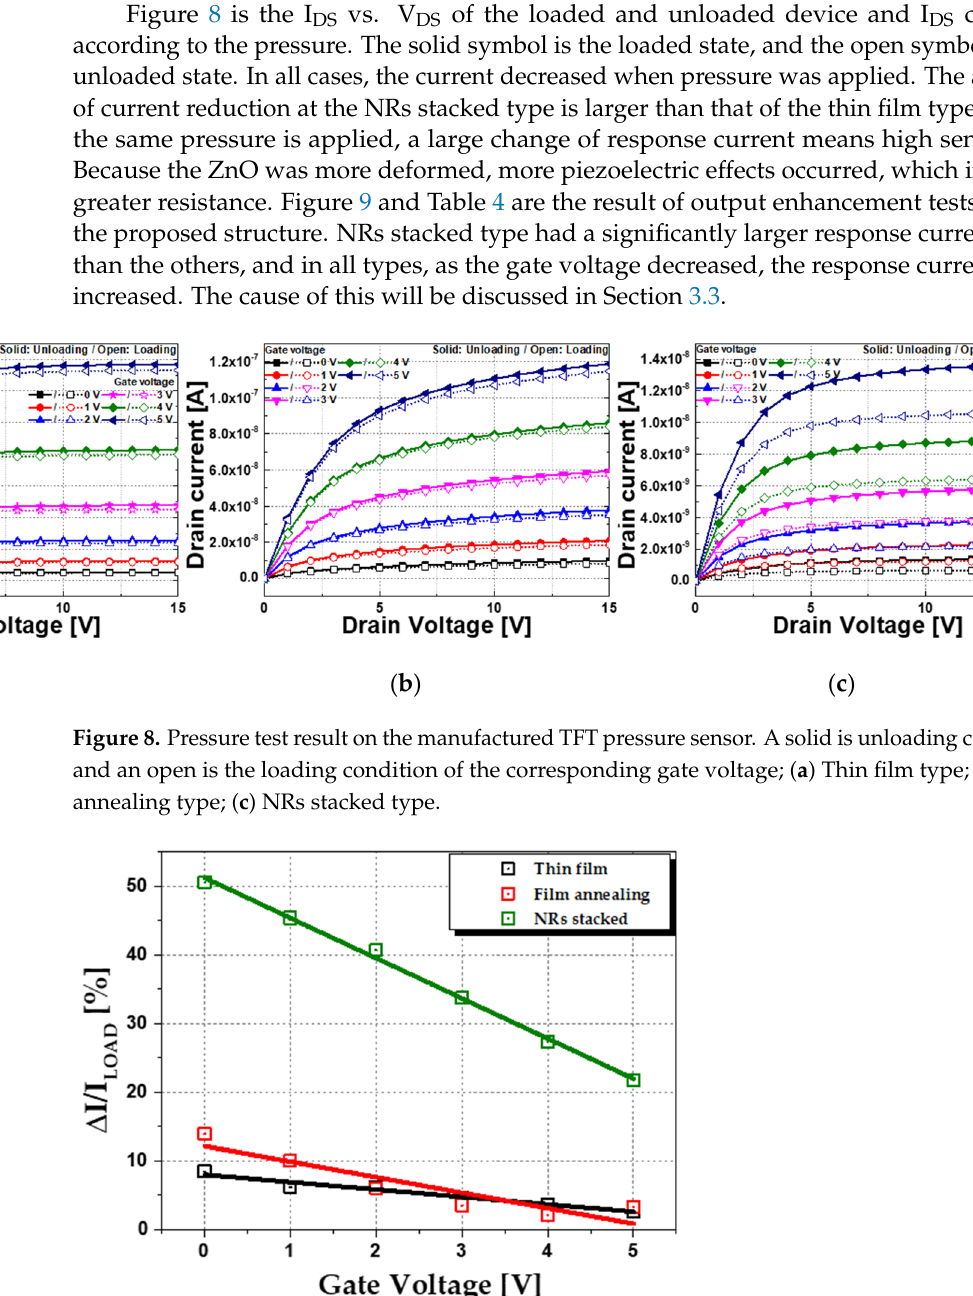
Figure 8 is the I DS vs. V DS of the loaded and unloaded device and I DS changes according to the pressure. The solid symbol is the loaded state, and the open symbol is the unloaded state. In all cases, the current decreased when pressure was applied. The amount of current reduction at the NRs stacked type is larger than that of the thin film type. When the same pressure is applied, a large change of response current means high sensitivity.